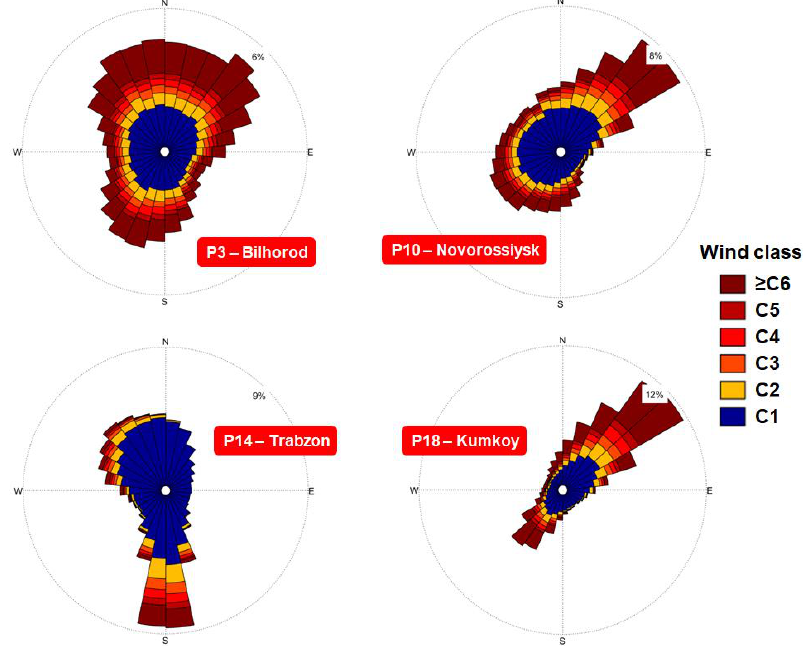
Figure 6. The directional wind distribution, expressed in terms of the wind classes (C1–C6). The full time distribution corresponds to the ERA-Interim data (January 1998–December 2017).